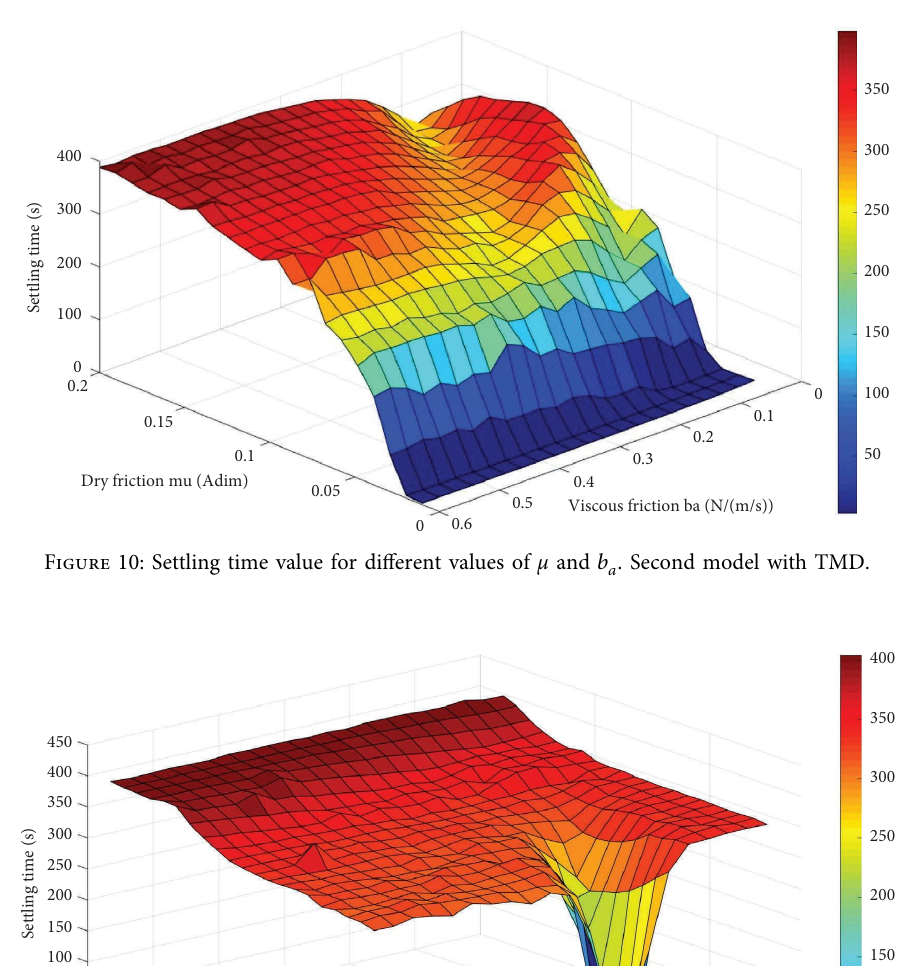
k a and a . Second model with TMD.